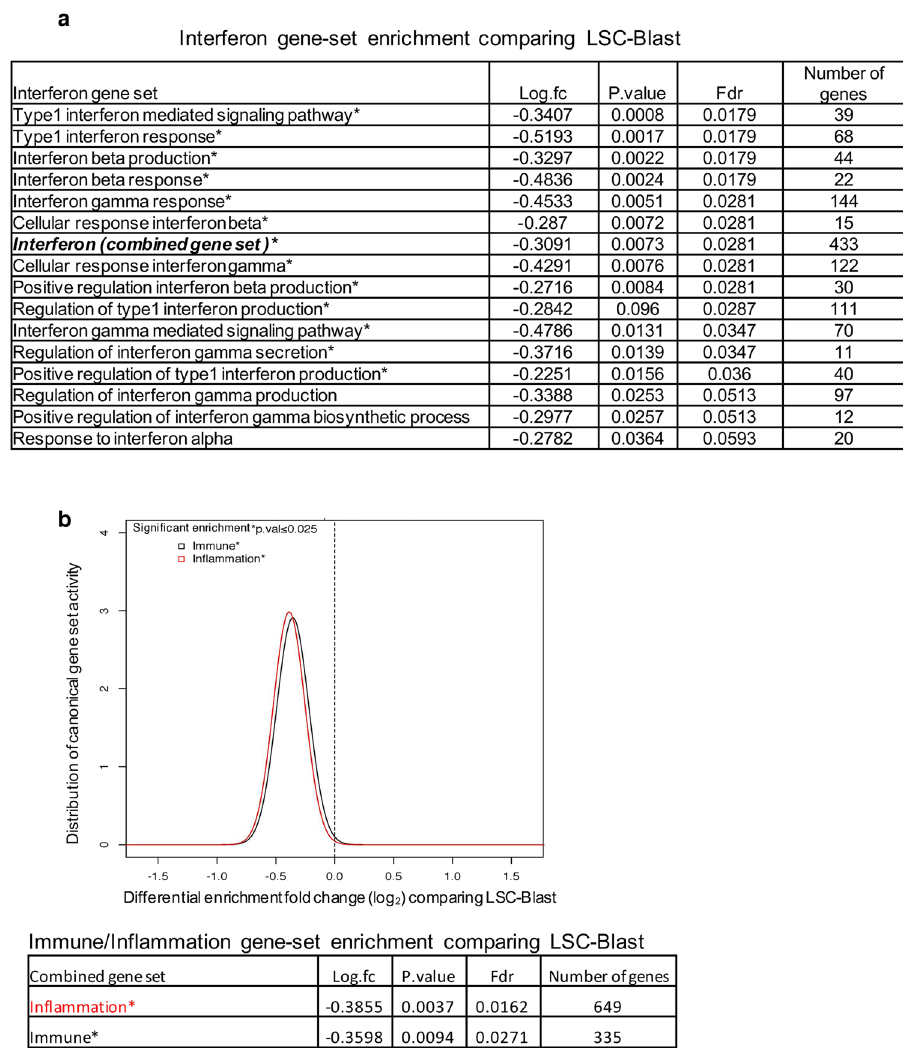
Figure 2. Analysis of gene set enrichment for interferon, inflammation, and immune response genes ( a ) Interferon-related gene sets from GO MSigDB, comparing LSCs and Blasts in AML. ( b ). Gene set enrichment analysis of combined inflammation and immune gene sets, comparing LSCs and Blasts. The Bonferroni multiple testing correction significance threshold is denoted as ‘p.val’. * indicates p <